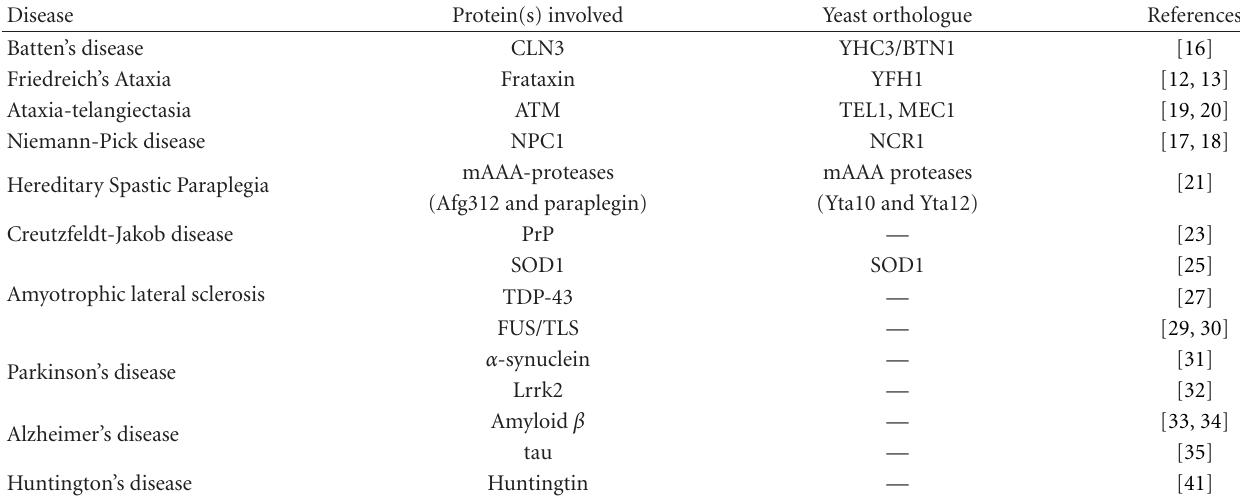
Table 1: Proteins associated with human neurodegenerative disorders studied in